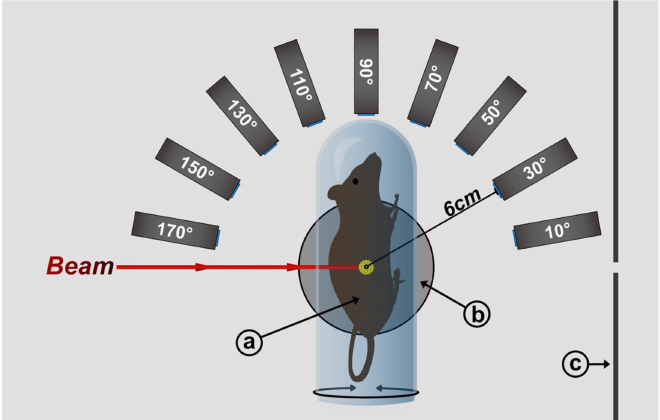
Figure 6. Illustration of the simulation setup as seen from above. ( a ) Rotational mouse voxel model enclosed in a plexiglass tube; ( b ) stage inlay + stage plate; ( c ) front